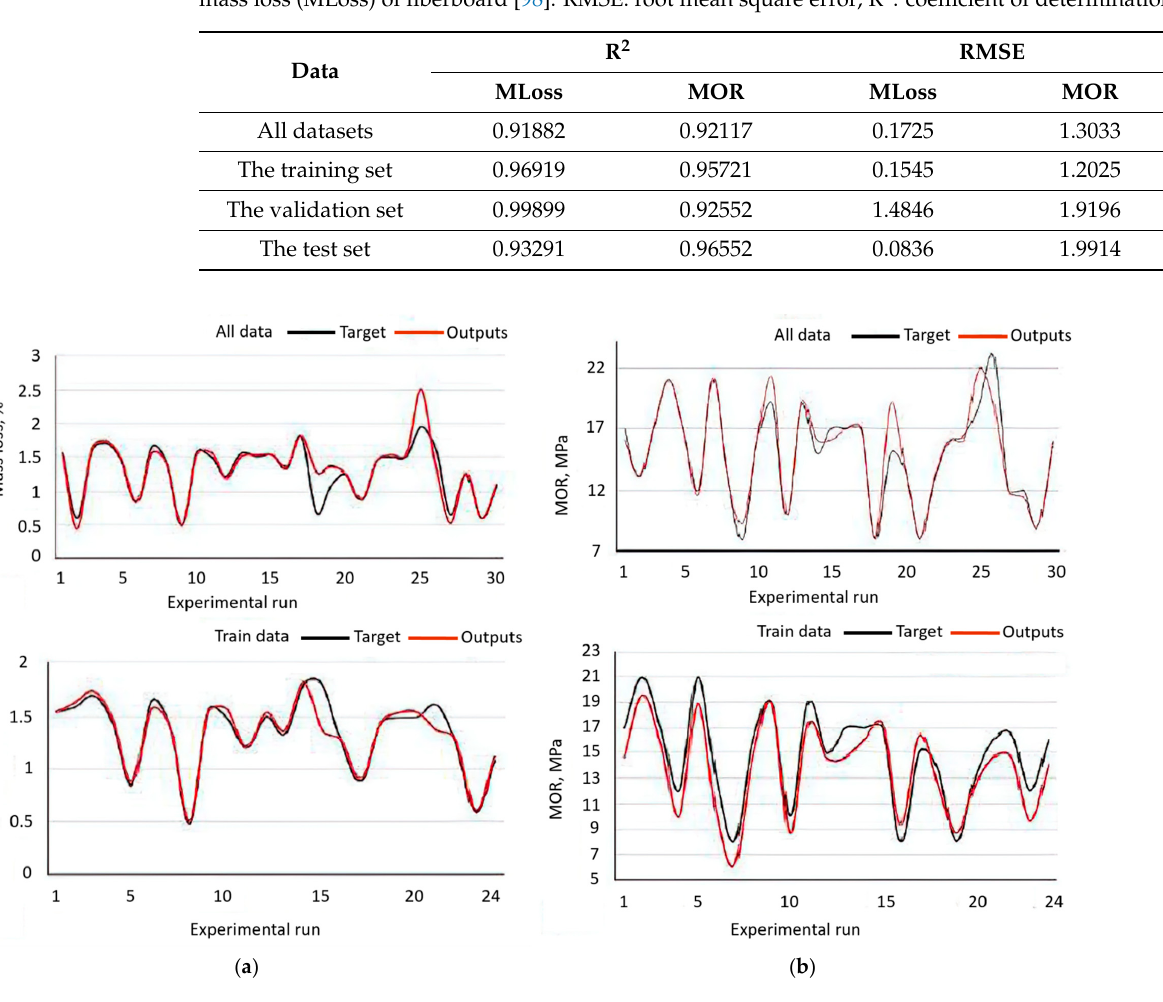
Figure 5. A comparison between the actual values (target) and predicted values (outputs) of the ( a ) Mass loss and ( b ) Modulus of Rupture in the cases of all data and train data. Adapted with permission from ref. [98]. Copyright 2020 Open Access & Springer.